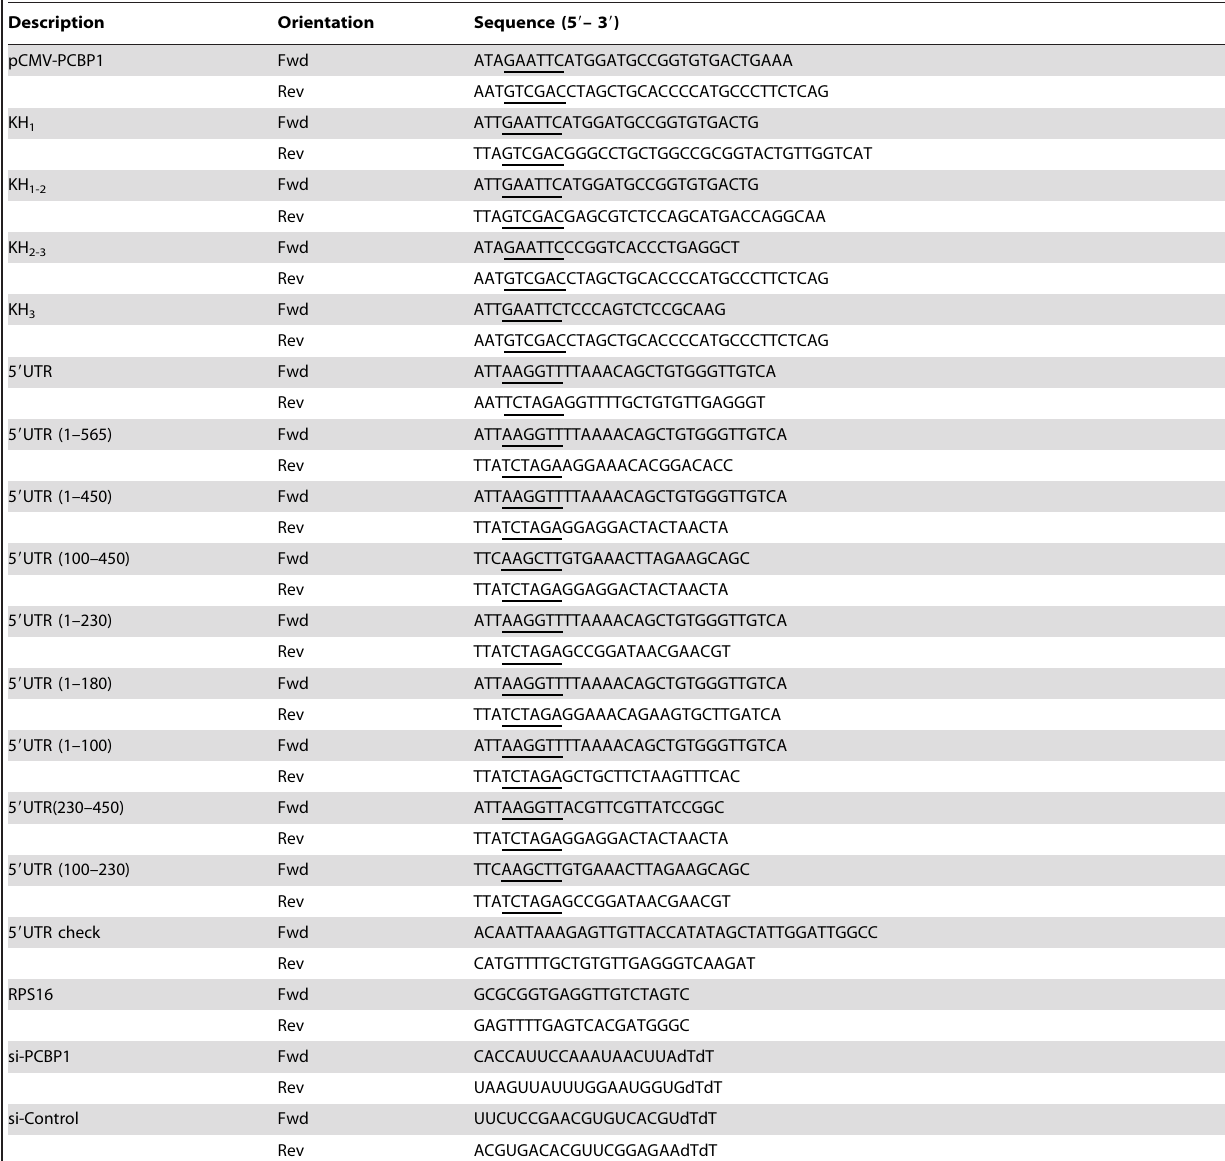
Description Orientation Sequence (5 9 – 3 9